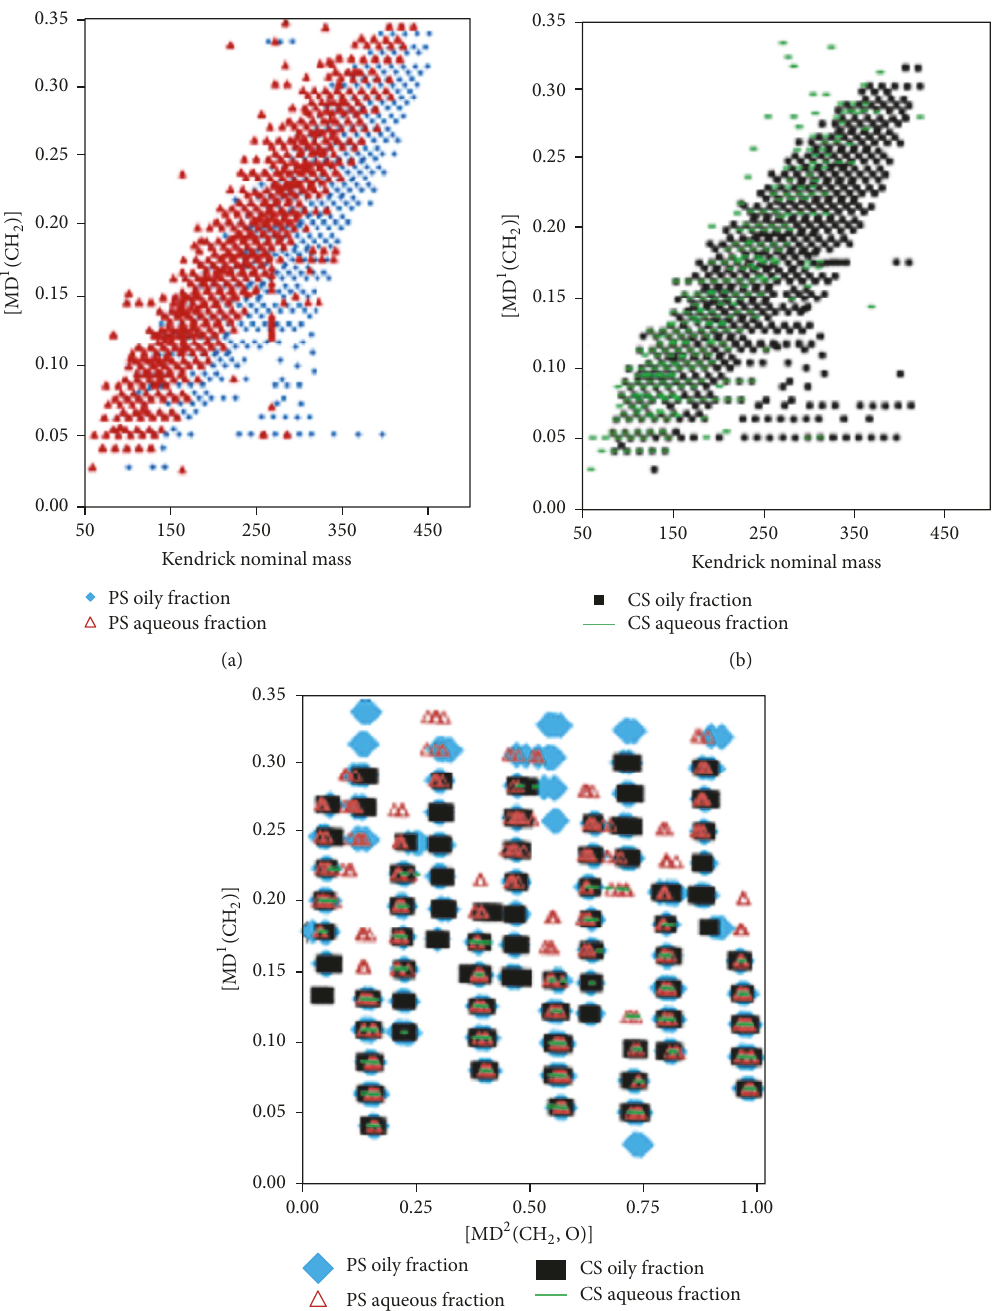
Figure 3: Kendrick mass defect (KMD) analyses for biooil fractions (plotted as a Kendrick mass of CH 2 )